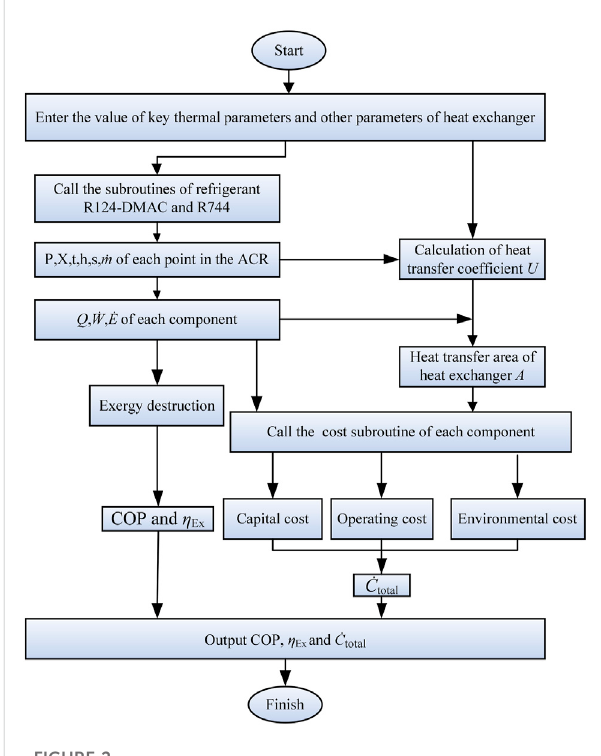
FIGURE 2 The simulation algorithm of combined absorption-compression cascade refrigeration